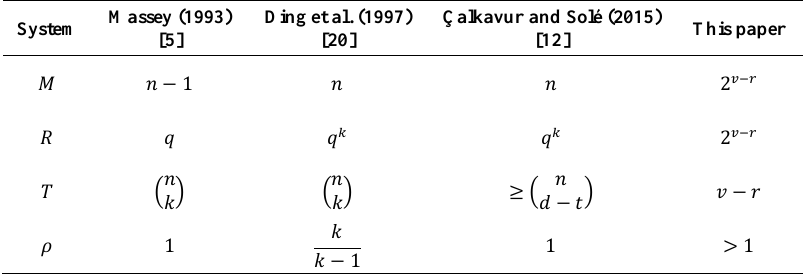
Table 1. Comparison with other